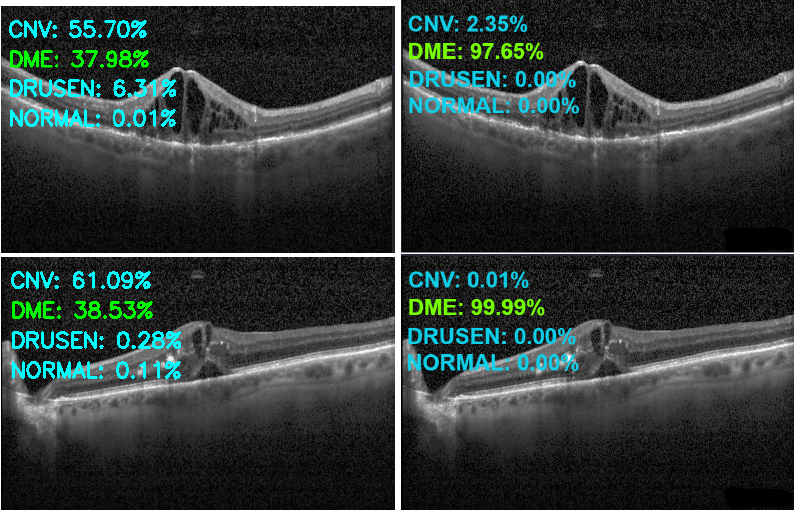
Figure 14. Exemplary result of proposed model trained without (left column) and with (right column) augmentation (correct label highlighted in green).